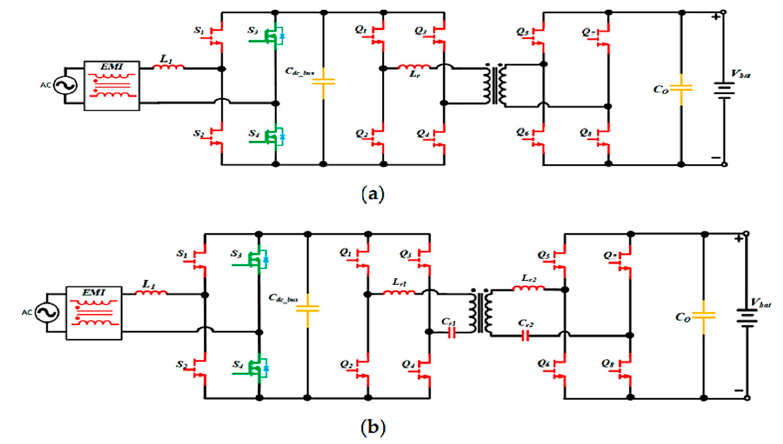
Figure 7. ( a , b ) Modular 600 kW DC ultra-fast charger [111].